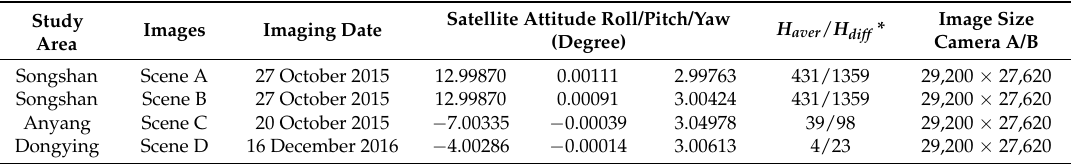
Table 2. Experimental data